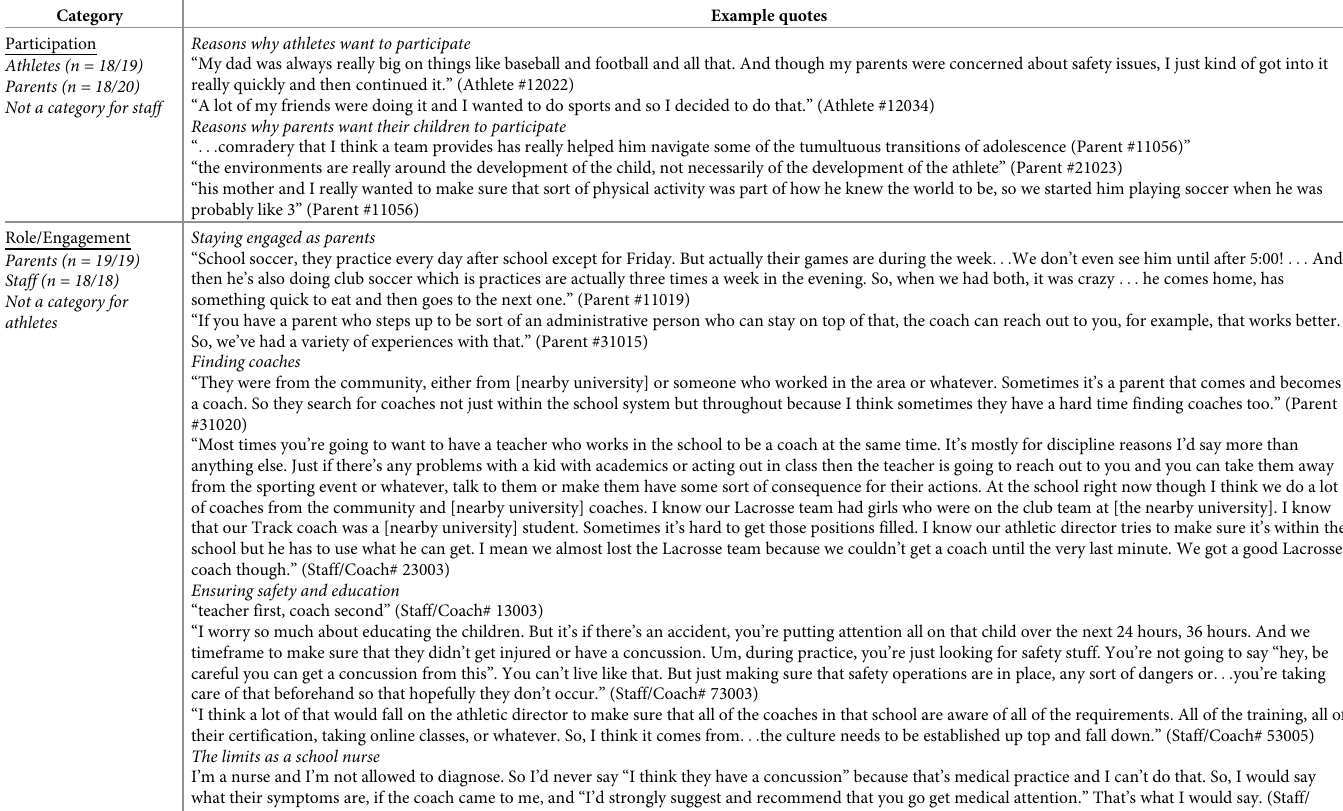
Table 3. Categories identified in interviews with middle school athletes, parents, and staff related to the category of “sport culture”. Category Example